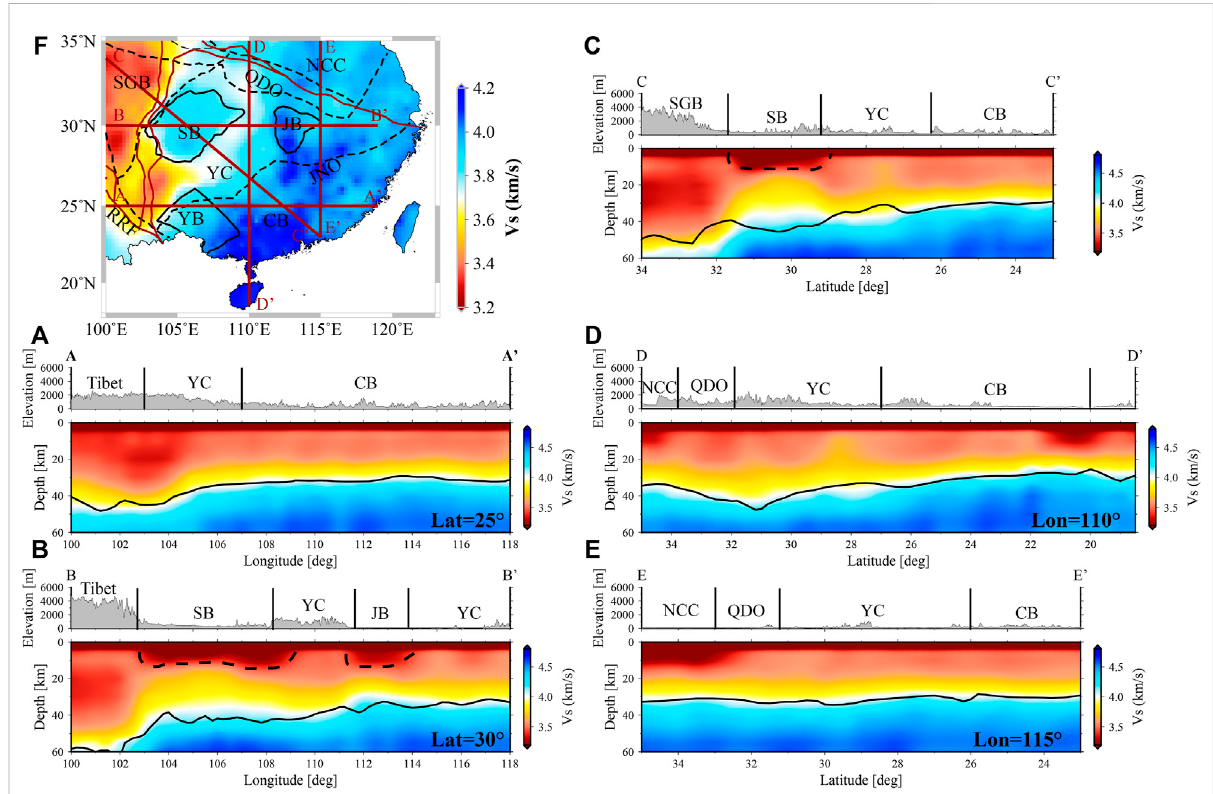
FIGURE 10 Vertical S-wavevelocity sections of thecrustal and uppermost mantle component of SREM-SC along pro fi les (A) latitudeat 25 ° N, (B) latitude at 30 ° N, (C) a diagonal pro fi le CC ′ , (D) longitude at 110 ° E; (E) longitude at 115 ° E. The pro fi le locations are shown in the map view (F) at 30 km. Moho depth of this study (solid black line) is also shown in the